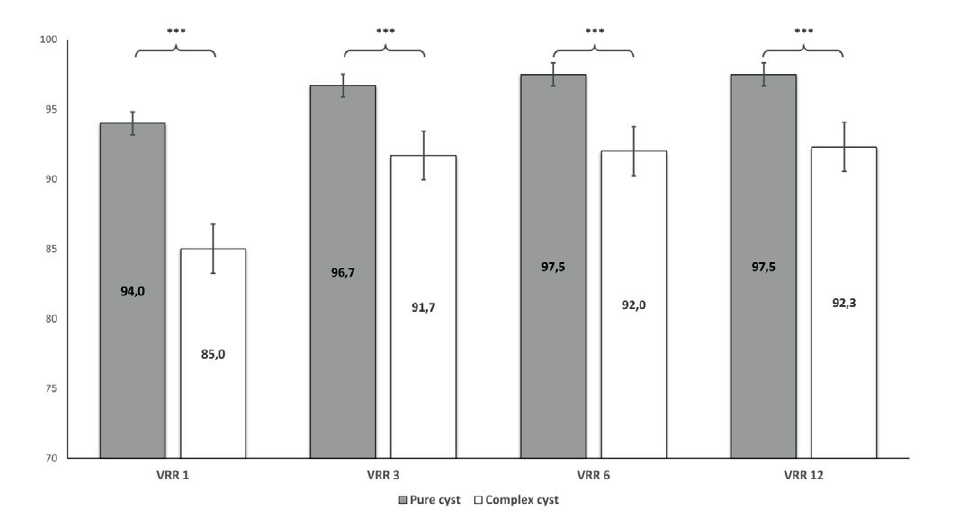
Fig. 4. Comparison of VRRs of complex and pure cysts at different months of follow up.